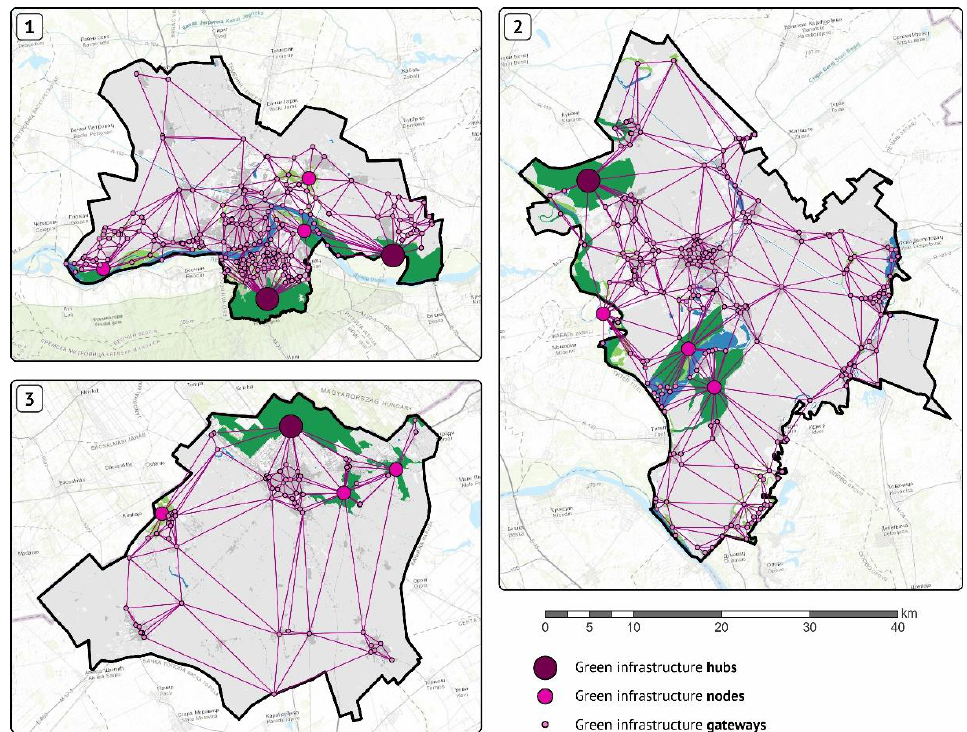
Figure 5. “ Ecological dimension ” of territorial cohesion: Green infrastructure elements in the ( 1 ) Municipality of Novi Sad, ( 2 ) Municipality of Zrenjanin, and ( 3 ) Municipality of Subotica. Table 4. Green infrastructure elements: hubs, nodes and gateways at the territory of (1) Municipality of Novi Sad; (2) Municipality of Zrenjanin; (3) Municipality of Subotica. Green Infrastructure